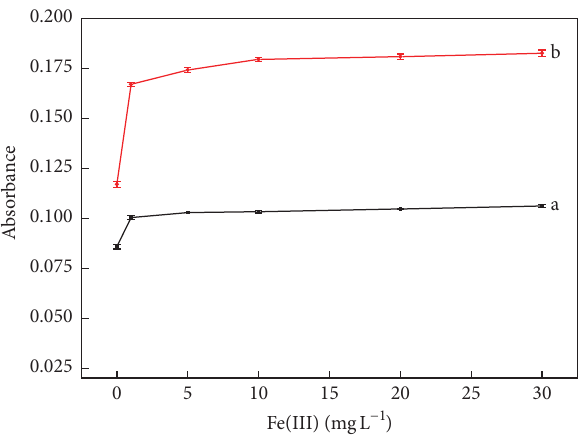
Figure 5: Effect of the sample slug volume. Curves a and b correspond to blank and the 150 𝜇 g L −1 Mo(VI) standard solution,